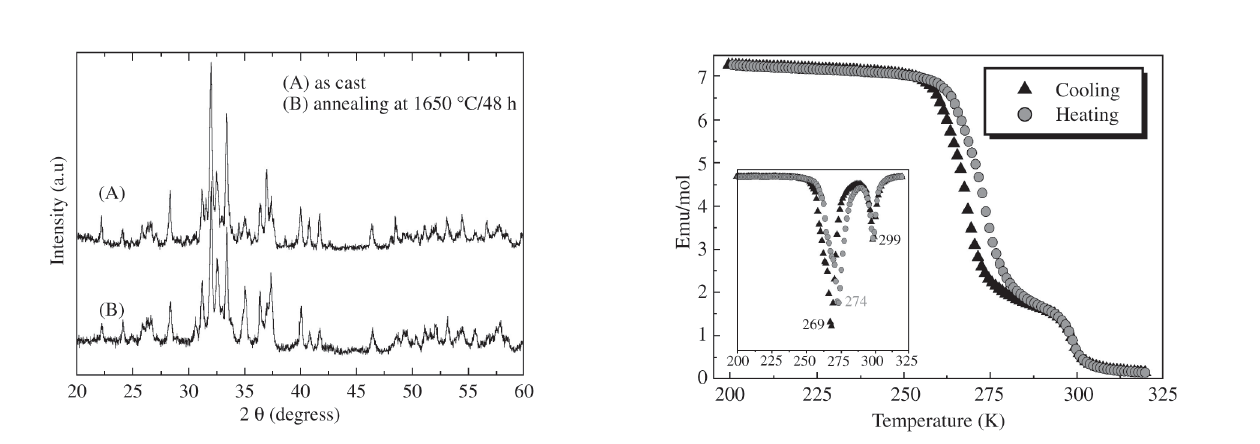
Figure 3. Comparison between the X-ray diffraction patterns for the as-cast and heat-treated alloy (45 kV, 30 mA, Cu-K α ). Figure 4. M vs. T measurement for the annealed Gd